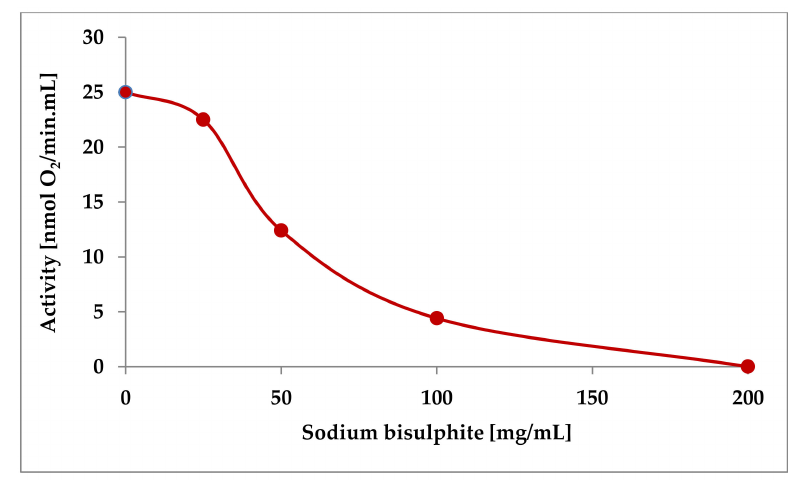
Figure 5. Influence of sulphite additions on the activity of a must laccase